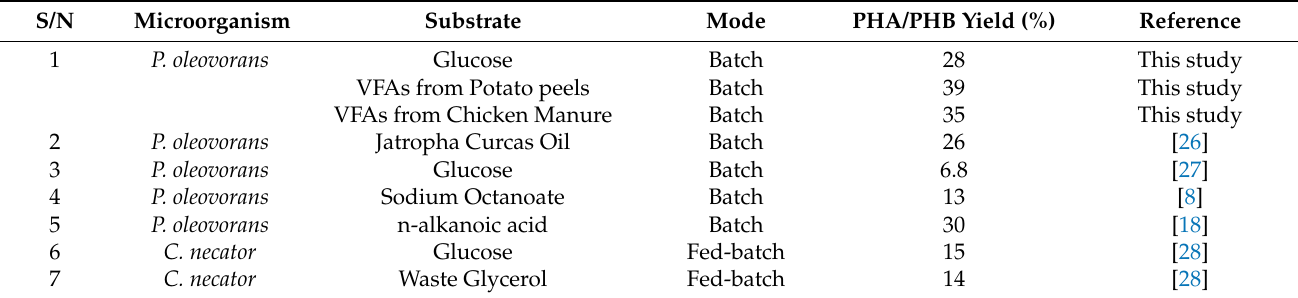
Table 6. Comparison of PHAs/PHB yield from various